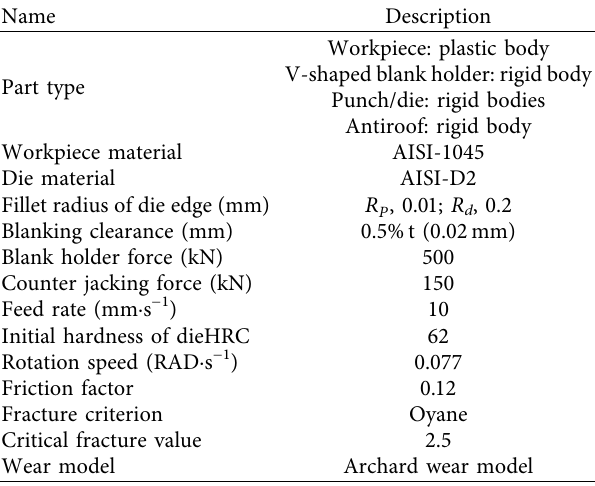
Table 2: Basic conditions of finite element model simulation.